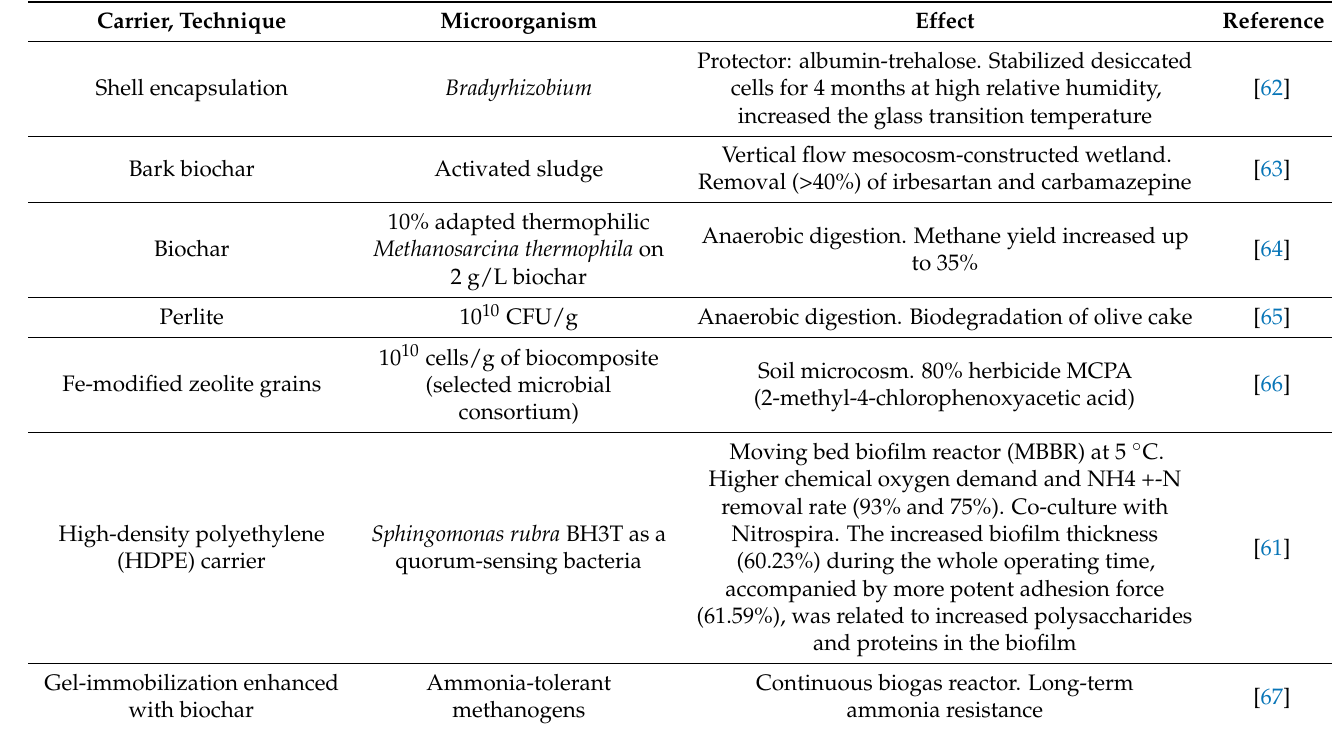
Table 2. Engineered materials for improvement in biofilm performance and in the shelf-life of desiccated microbial